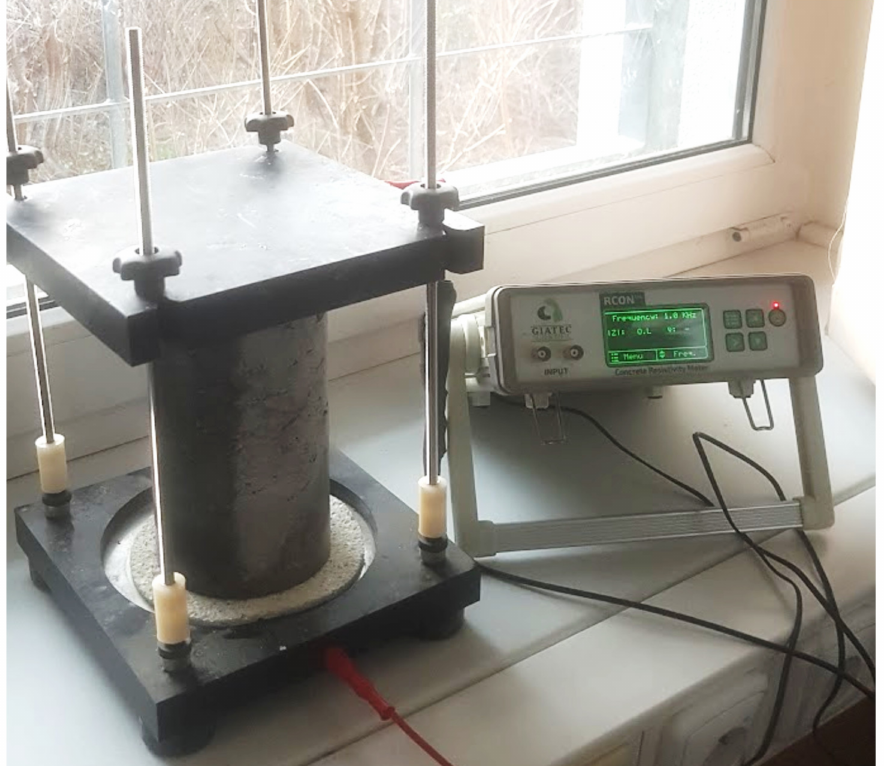
Figure 1. Experimental testing of the electrical resistivity of concrete in